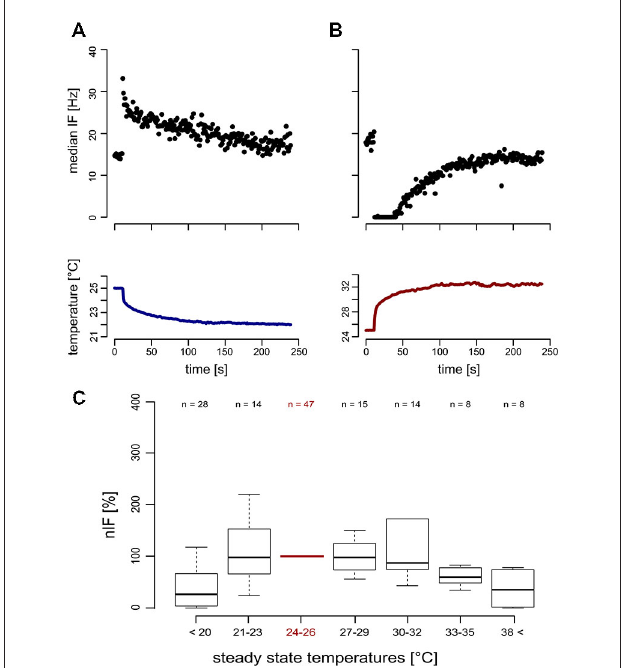
FIGURE 4 | Neuronal response (top) of transient temperature detectors (TT-neurons) and temperature stimulation (bottom). (A) Phasic increase of neuronal activity in a TT-neuron during cold stimulation (blue). (B) Reduced neuronal activity of a second TT-neuron during heat stimulation (red). (C) The normalized instantaneous frequency (nIF) during steady state temperature conditions was stable in a temperature range from 21 ◦ C to 35 ◦ C, indicating a working range of TT-neurons of at least 14 ◦ C.